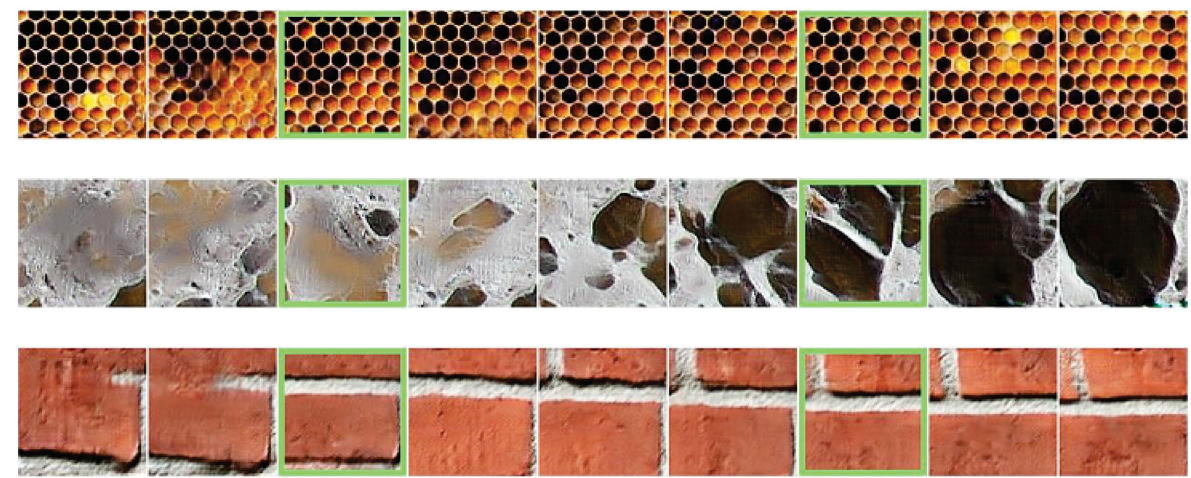
Fig. 15 Texture interpolation and extrapolation. Examples of interpolated and extrapolated textures, generated between two sample co-occurrence vectors (corresponding to the generated images marked in green). As the figure illustrates, the extrapolated examples extend the smooth interpolation sequence, magnifying the differences in the local texture properties. Please refer to the accompanying video in the ESM for the full dynamic sequences. (cid:2) The co-occurrence matrix corresponding to Texture 1 is (a) in both